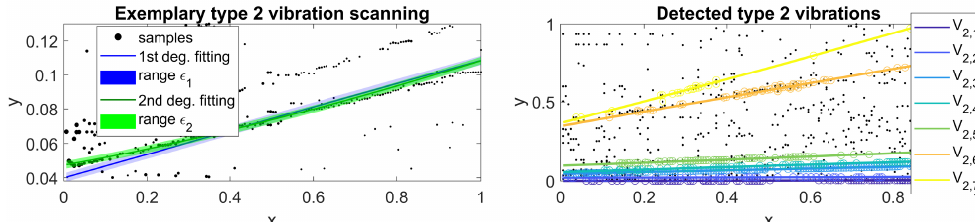
Figure 9. Vibration scanning for detecting Type 2 vibrations. Peaks related to Type 2 vibrations P v 2 displayed as samples with x and y axes normalised to [0,1]. ( Left ) Exemplary fitting for first-degree polynomial y 1 ( x ) and second-degree polynomial y 2 ( x ) and corresponding ranges (cid:101) 1 and (cid:101) 2 . ( Right ) Models y 2, j ( x ) corresponding to Type 2 vibrations V 2, j for vibrations j 2 = 2